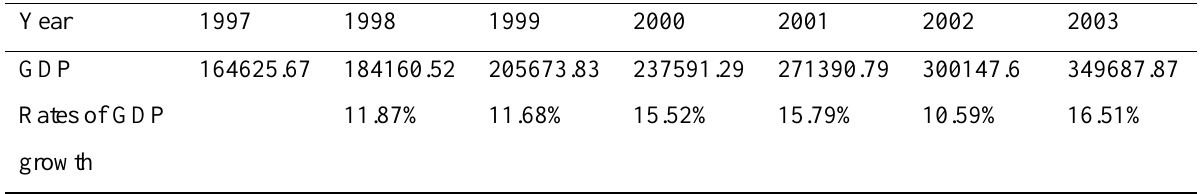
Table 7. The 5 years GDP and change rate of Guangzhou Municipality (Million